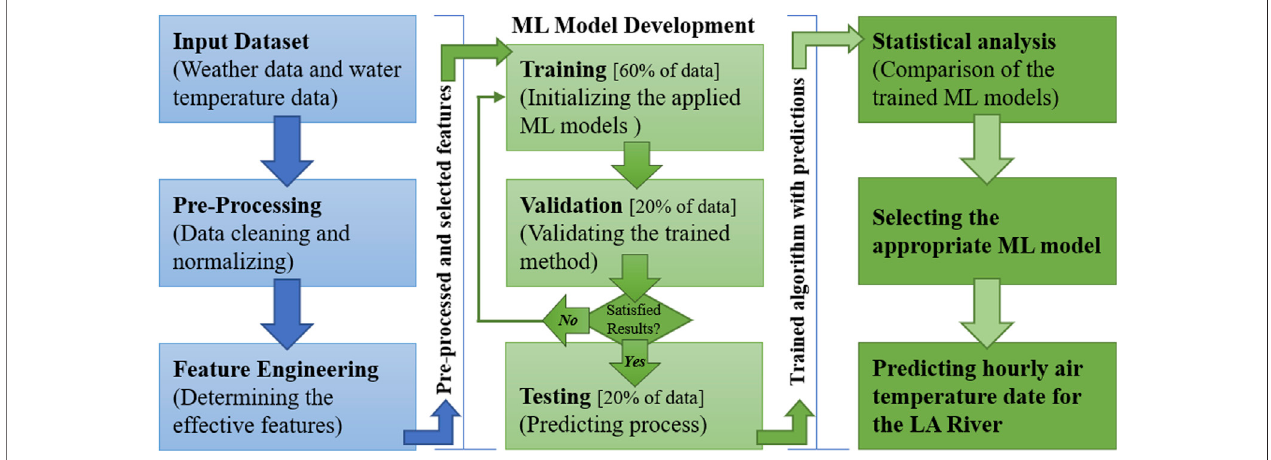
FIGURE 2 | The schematic diagram of the steps for data gathering, cleaning, and organizing, as well as ML model ’ s development and generating the predicted values based on the trained model to evaluate their performance.